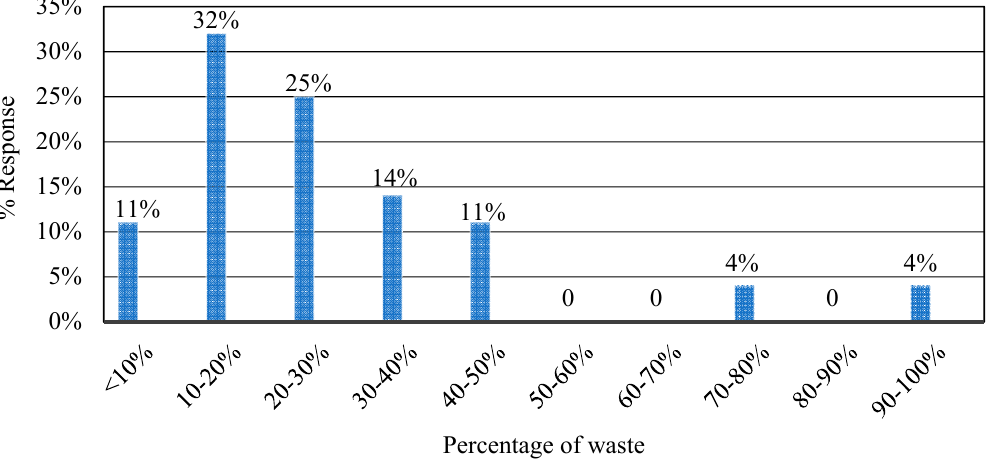
Figure 9. Figure 9. Percentage of responses regarding the amount of waste which can be found during construction.